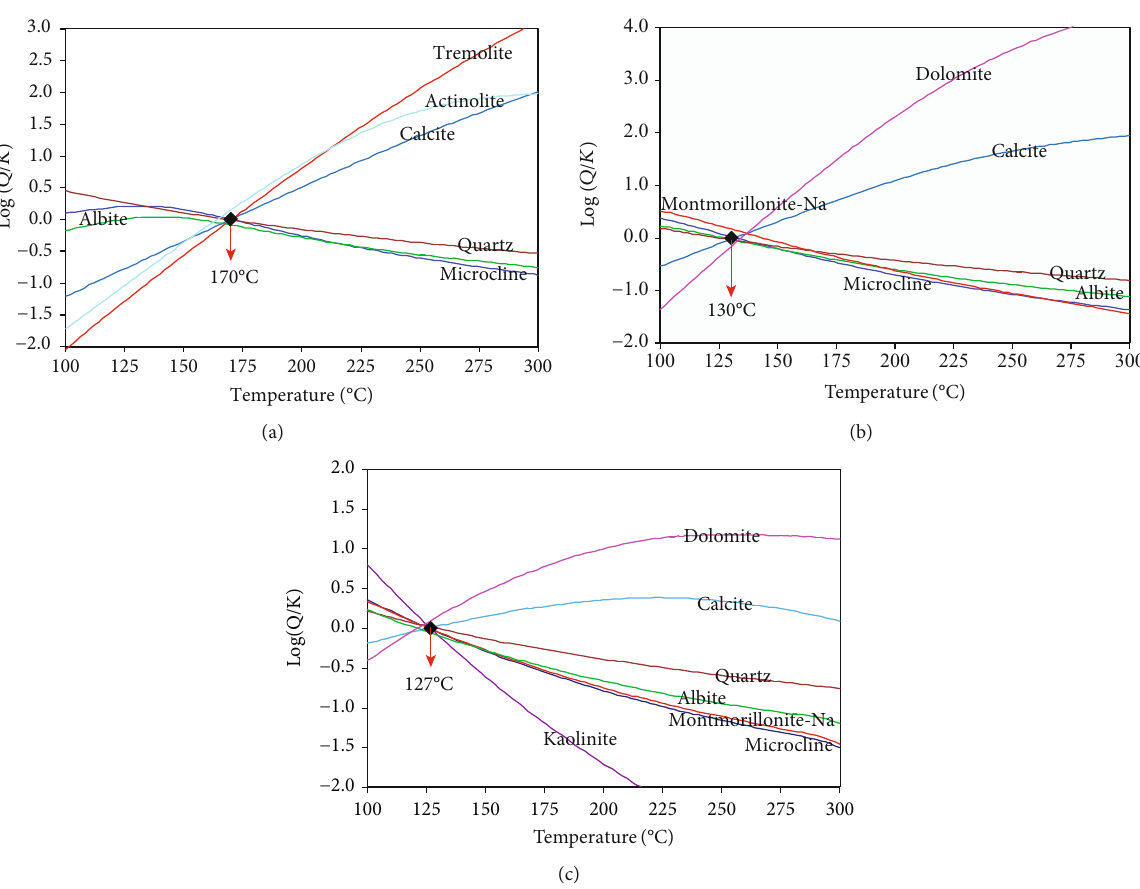
Figure 5: Mineral saturation index variation with temperature for (a) G03 water sample in Jinjiang springs, (b) G07 water sample in Shibadaogou springs, and (c) G10 water sample in Xianrenqiao